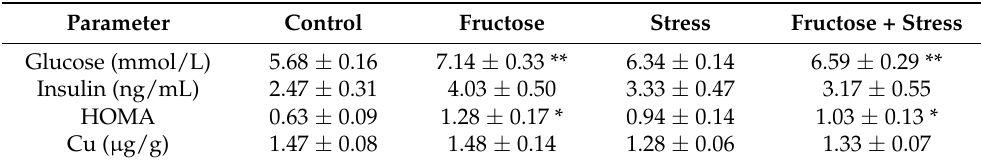
Table 1. Effects of liquid fructose supplementation and/or stress on plasma parameters.